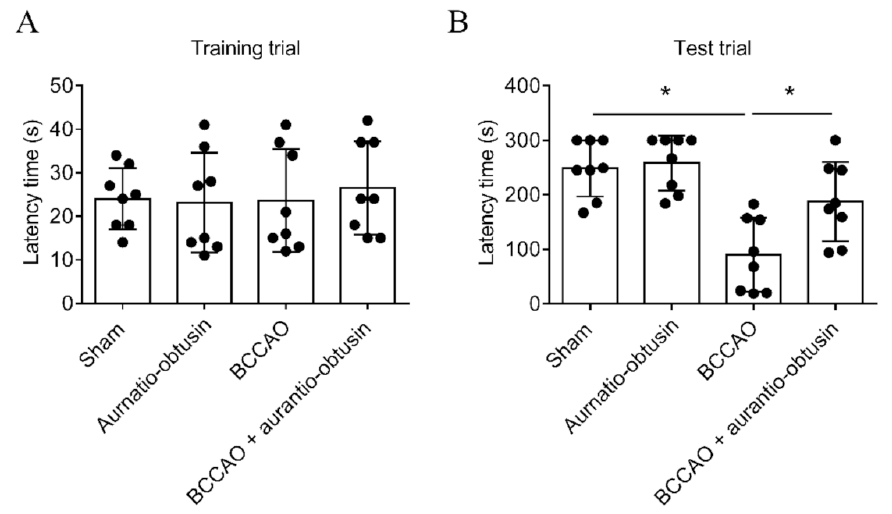
Figure 4. Effect of aurantio-obtusin on transient forebrain ischemia-induced memory impairment in